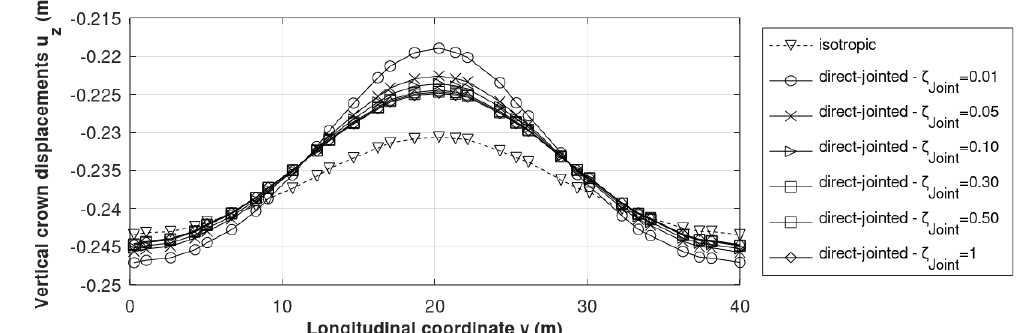
Fig. 13. Effect of shear stiffness reduction ζ